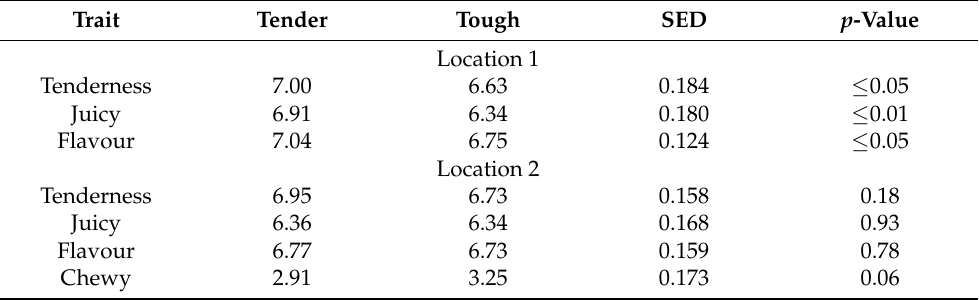
Table 3. Trained sensory panel data: least squares means and standard error of the difference (SED) for the different sensory attributes measured in Location 1 (scale 1 (poor) to 9 (good)) and Location 2 (scale 1 (poor) to 10 (good)) for both the genetically Tender and Tough genotypes.